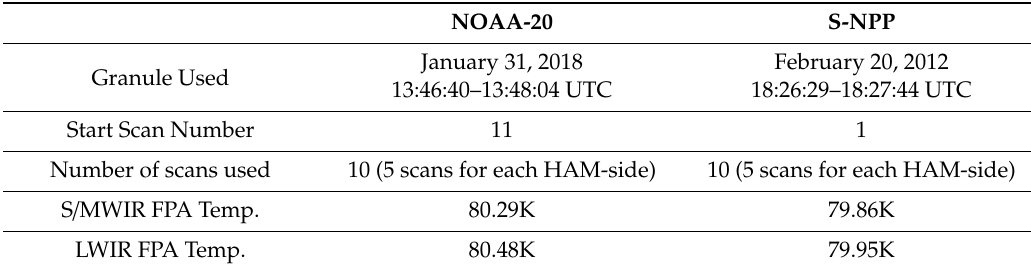
Table 2. NOAA-20 and S-NPP pitch maneuver data used for on-orbit Response Versus Scan (RVS) characterization.